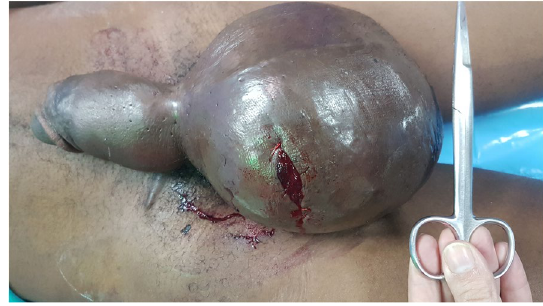
Fig. 3 Hematoma in a 16-year-old boy after hidrocelectomy, which required surgical